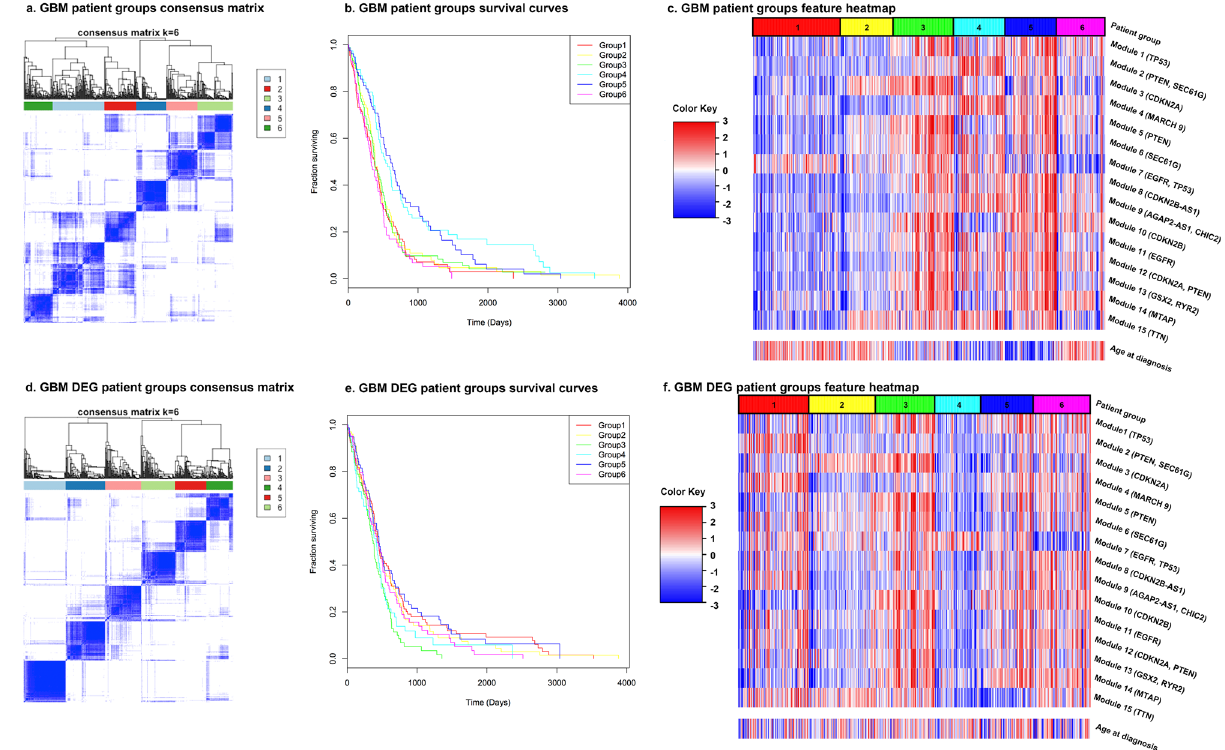
Figure 4. The consensus matrices of PAM consensus clustering for identifying patient groups for GBM, the survival curves of the resulting patient groups, and the feature heatmaps. Patient groups were identified using all DEG modules and clinical features. DEG patient groups were identified using only DEG modules. For the heatmaps, the features were normalized across all patients. Values above 3 and below -3 are compressed into 3 and -3, respectively. The dominant SGAs of each DEG module are listed by the module index. The values of the clinical features of each DEG patient group are also given as a